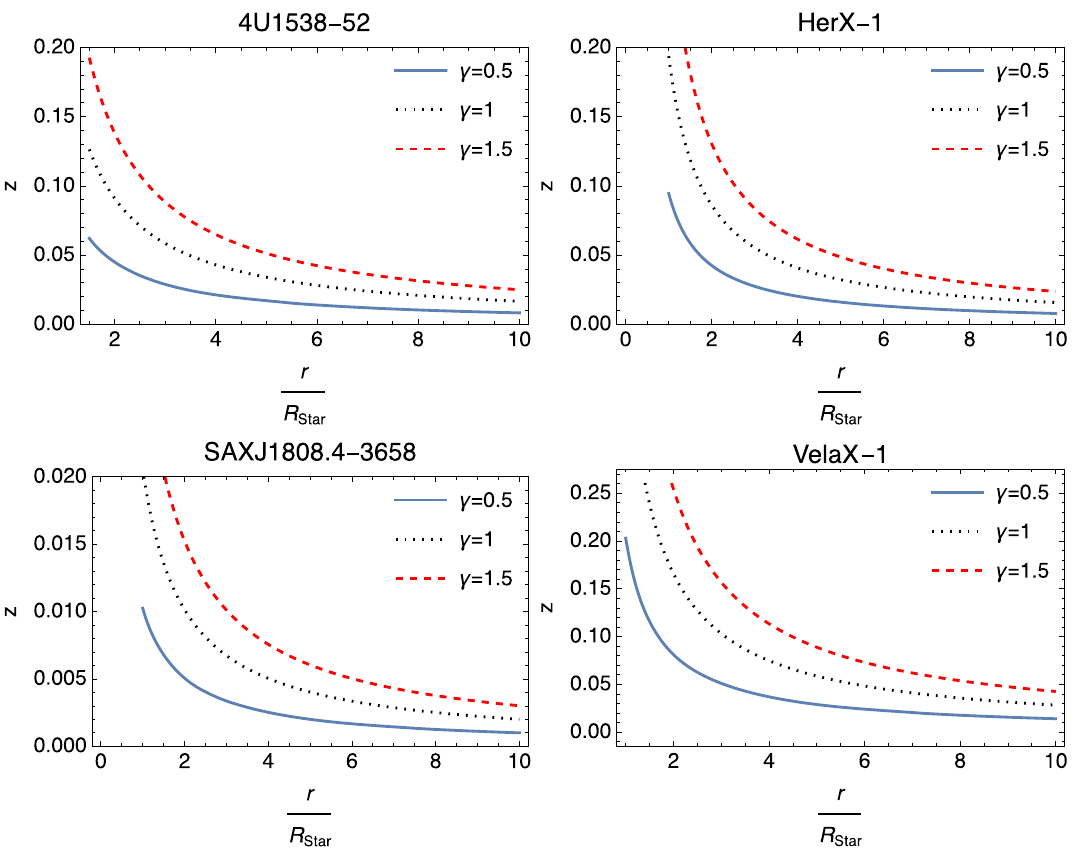
Fig. 18 Overlapping plots indicating variation in the redshift z against r for the compact objects given in Table 1 are plotted for comparison. R Star Each plot displays the effect of the deformation parameter γ on the redshift z . Plots are generated for the charged ZV case for a particular value